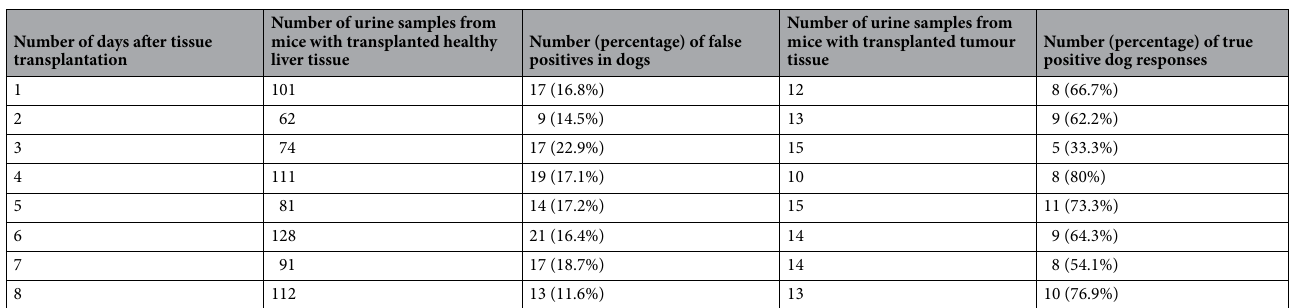
Table 4. The number of urine samples from mice with transplanted tissue for each of the eight days after transplantation.